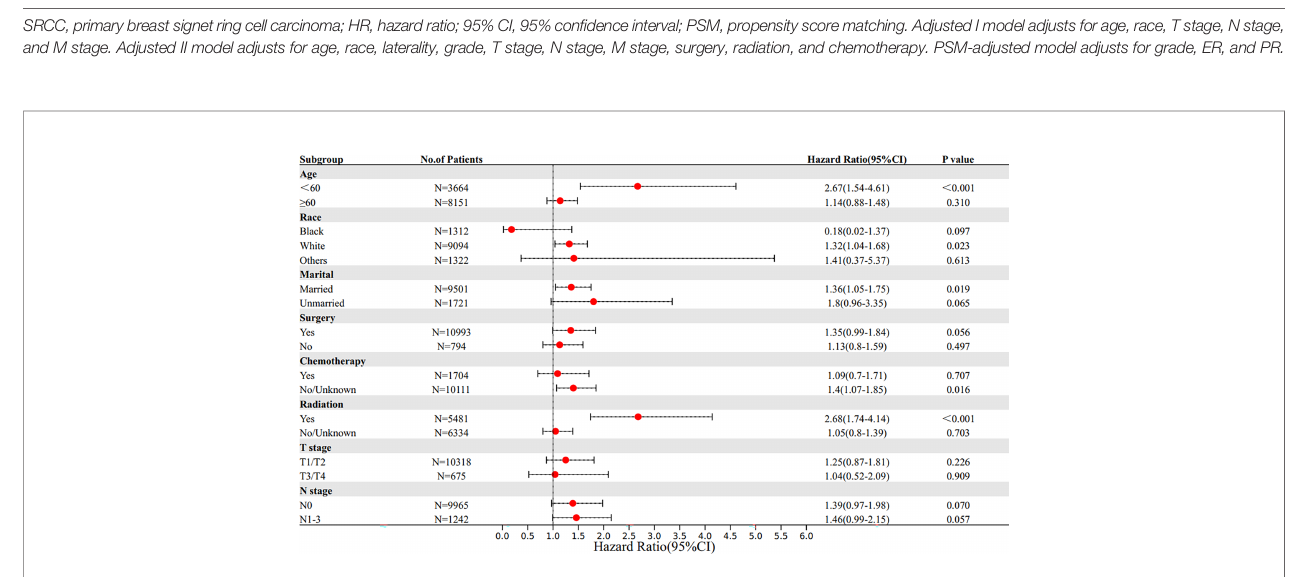
FIGURE 4 | Subgroup multivariate Cox proportional hazards model comparing BCSS between SRCC and MBC. OS, overall survival; SRCC, primary breast signet ring cell carcinoma; MBC, mucinous breast